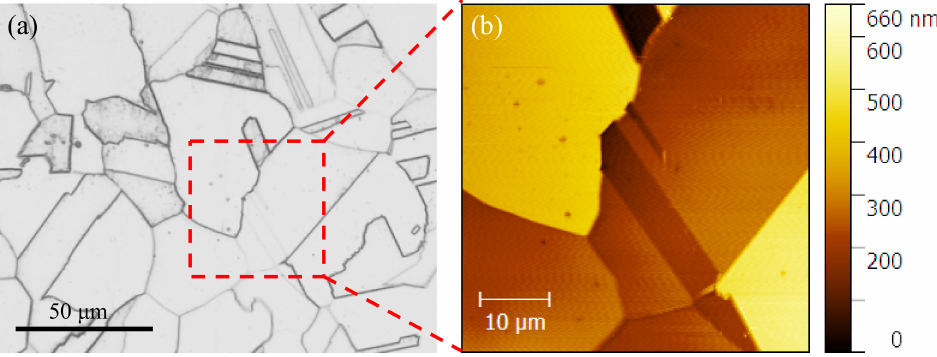
Figure 1. Microstructure of ST 316L: ( a ) OM image and ( b ) AFM image.